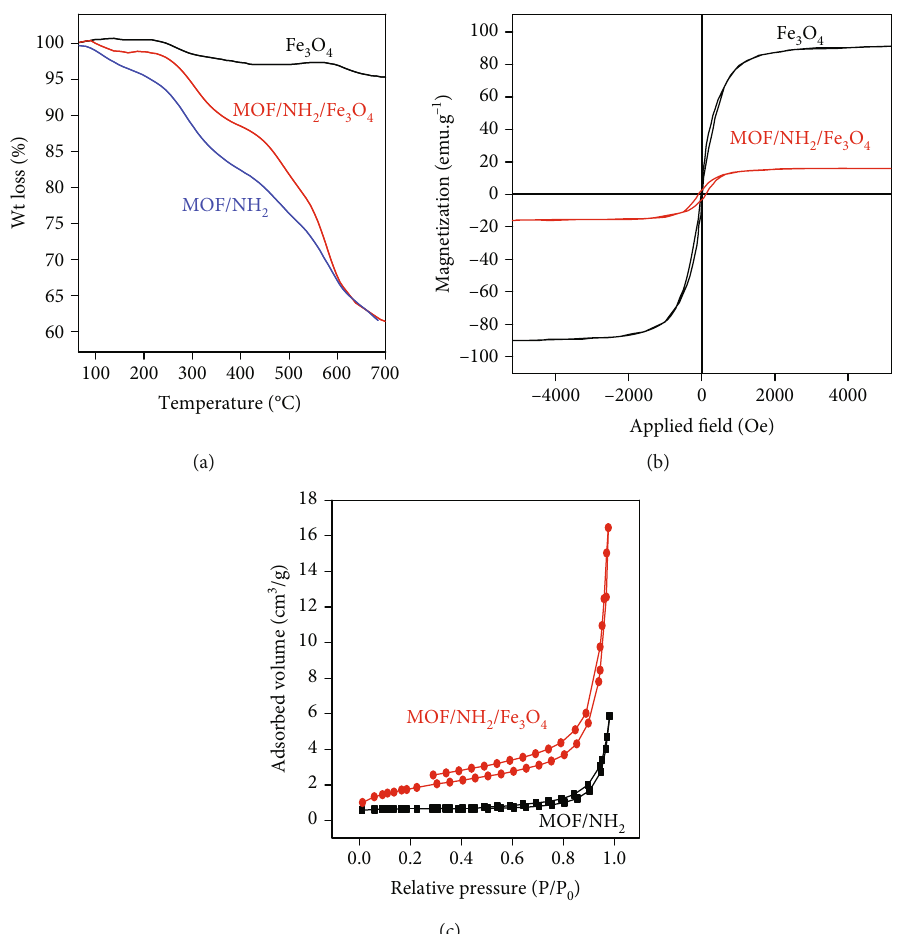
Figure 3: TGA curve (a), magnetization curve (b), and N MOF/NH , and MOF/NH 2